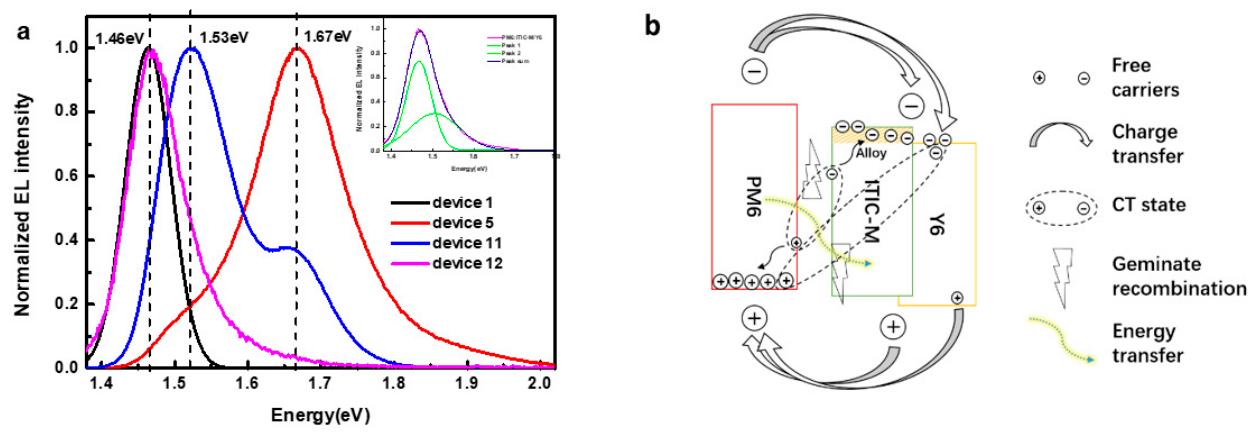
Figure 6. ( a ) EL spectroscopy of device 1, 5, 11 and 12 (inset image is multiple peaks Gaussian fitting of device 12), ( b ) charge transfer model of PM6:Y6:ITIC-M ternary solar cells.